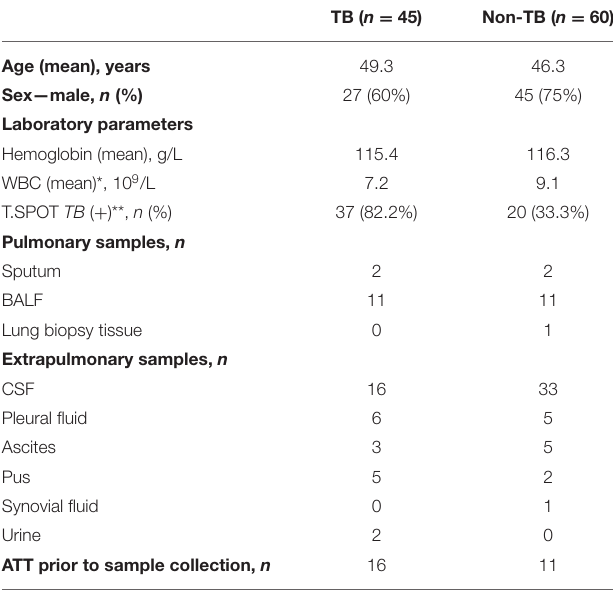
TABLE 1 | Baseline characteristics of the study